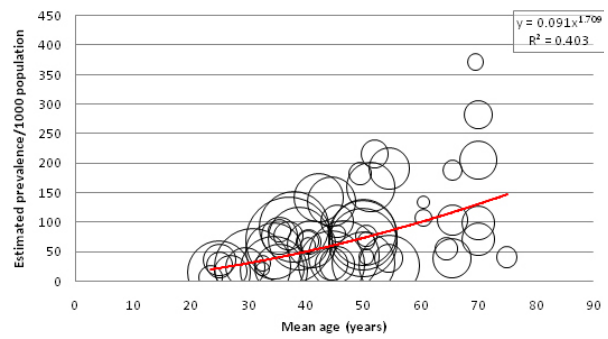
Figure 9. Crude prevalence of type 2 diabetes in Southern Asia in rural regions and its relationship with